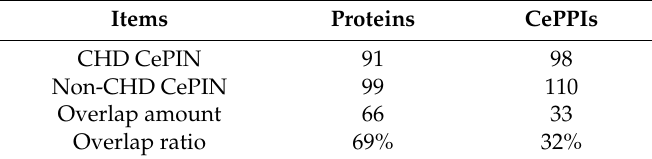
Table 2. Structural analysis of coexpression protein interaction networks (CePIN).